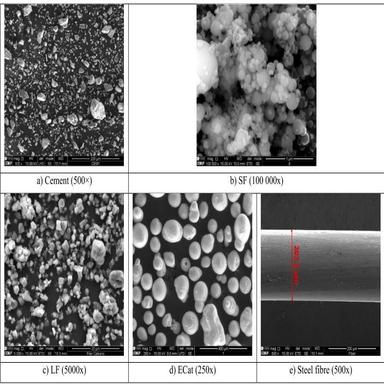
Secondary electron mode SEM image of: a) cement particles; b) Silica fume particles; c) Limestont filler particles; d) Ecat particles; e) a micro Steel fibre.